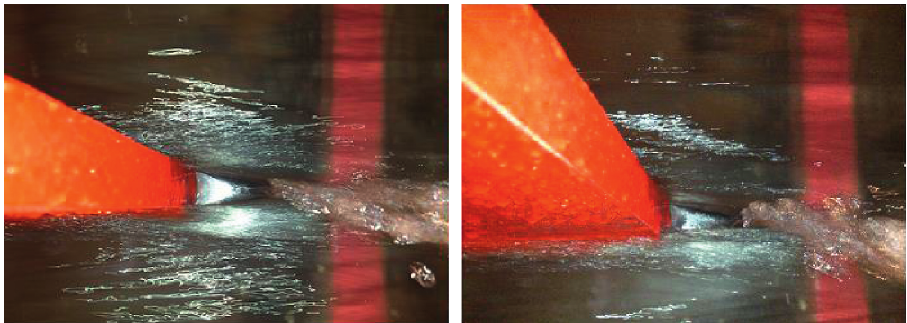
Figure 5: Cavity formation behind the